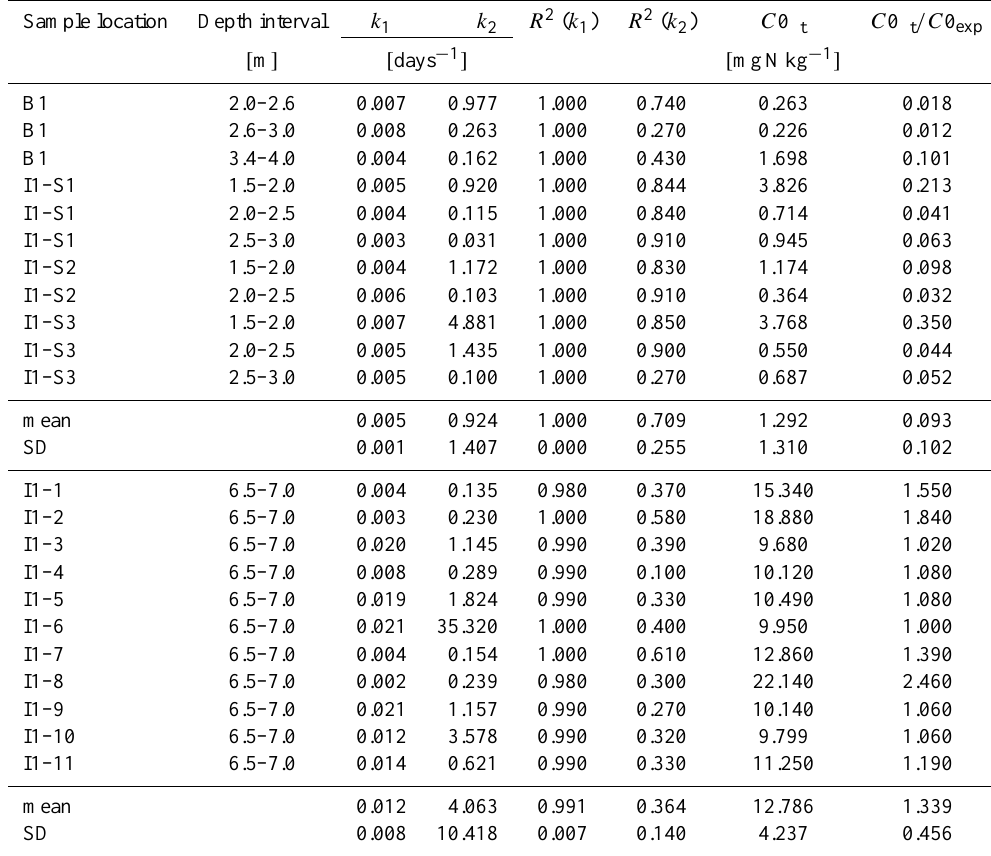
Table 4. Rate constants for heterotrophic and autotrophic denitrification derived from the sequential 3-parameter fit. R 2 ( k 1 ) and R 2 ( k 2 ) denote the correlation coefficients for the (N 2 O+N 2 ) -data and the N 2 O-data, respectively. The initial nitrate concentration C 0 was used as the third fitting parameter. The ratio of the fitting value and the experimental value is given in the last column and SD denotes the standard